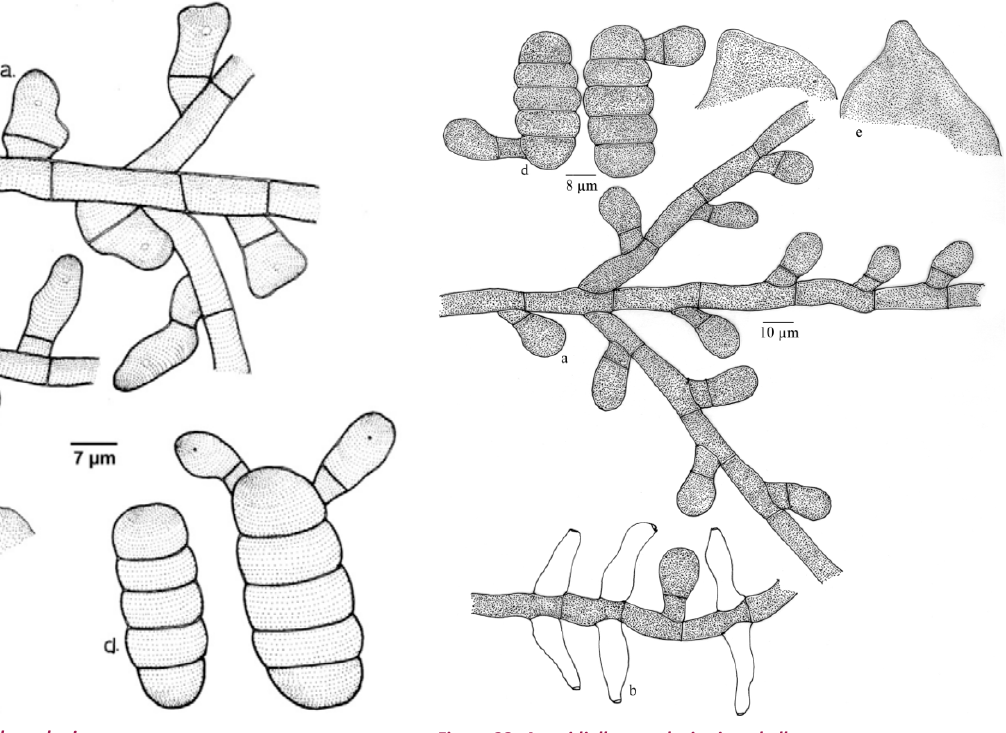
Figure 23. Asteridiella symploci-microphyllae a - Appressorium; b - Phialide; d - Ascospores; e - Perithecial wall